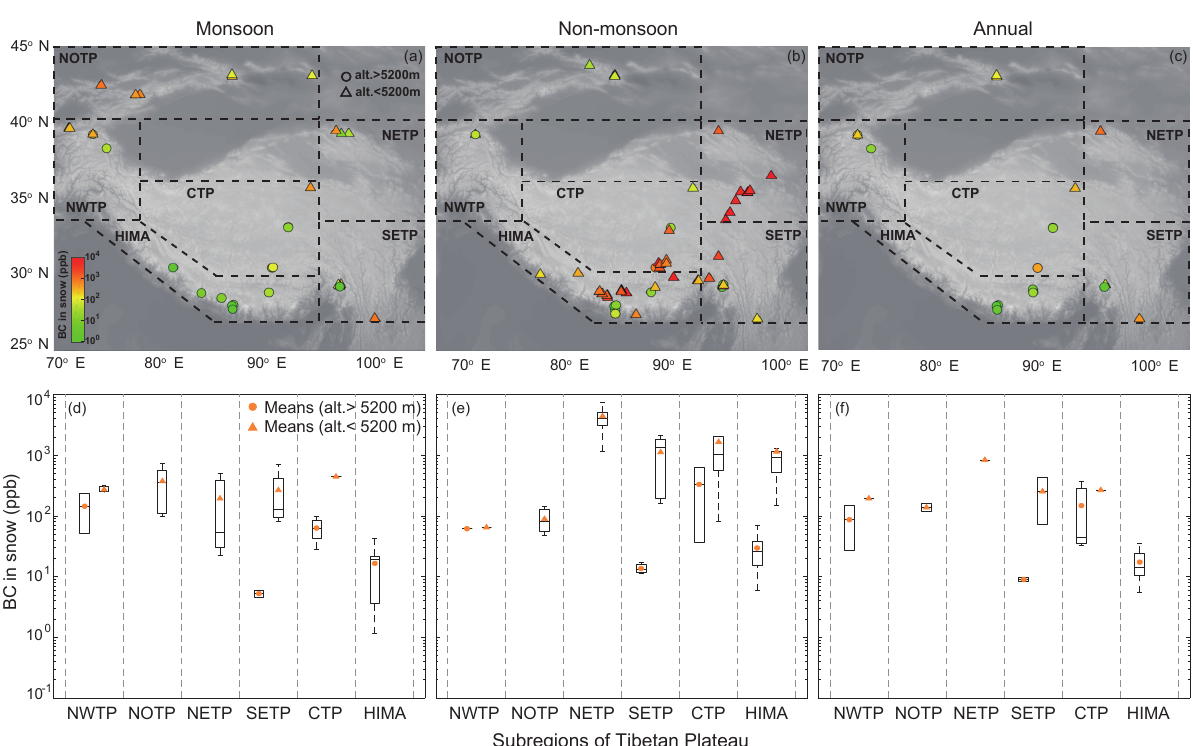
Figure 1. Observed BC concentrations in snow over the Tibetan Plateau (TP) during (a, d) monsoon, (b, e) non-monsoon, and (c, f) annual periods in 2000–2015 (see Table S1 for details). (a–c) Spatial distributions of seasonal mean BC concentrations at altitudes >5200 (circles) and <5200m (triangles) in six sub-regions, including the northwestern TP (NWTP), north of the TP (NOTP), the northeastern TP (NETP), the southeastern TP (SETP), the central TP (CTP), and the Himalayas (HIMA). (d–f) Box plots of observed BC concentrations in snow (shown in a–c ) within each sub-region, with medians (middle bars), interquartile ranges (between 25th and 75th percentiles; boxes), and maxima/minima (whiskers) within ± 1.5 × interquartile ranges. Some box plots are shrunk due to limited samples. Results for altitudes >5200 and <5200m are shown as left and right box plots within each sub-region, respectively, with circles and triangles indicating mean values. Note that some sub-regions only have observations at altitudes >5200 or